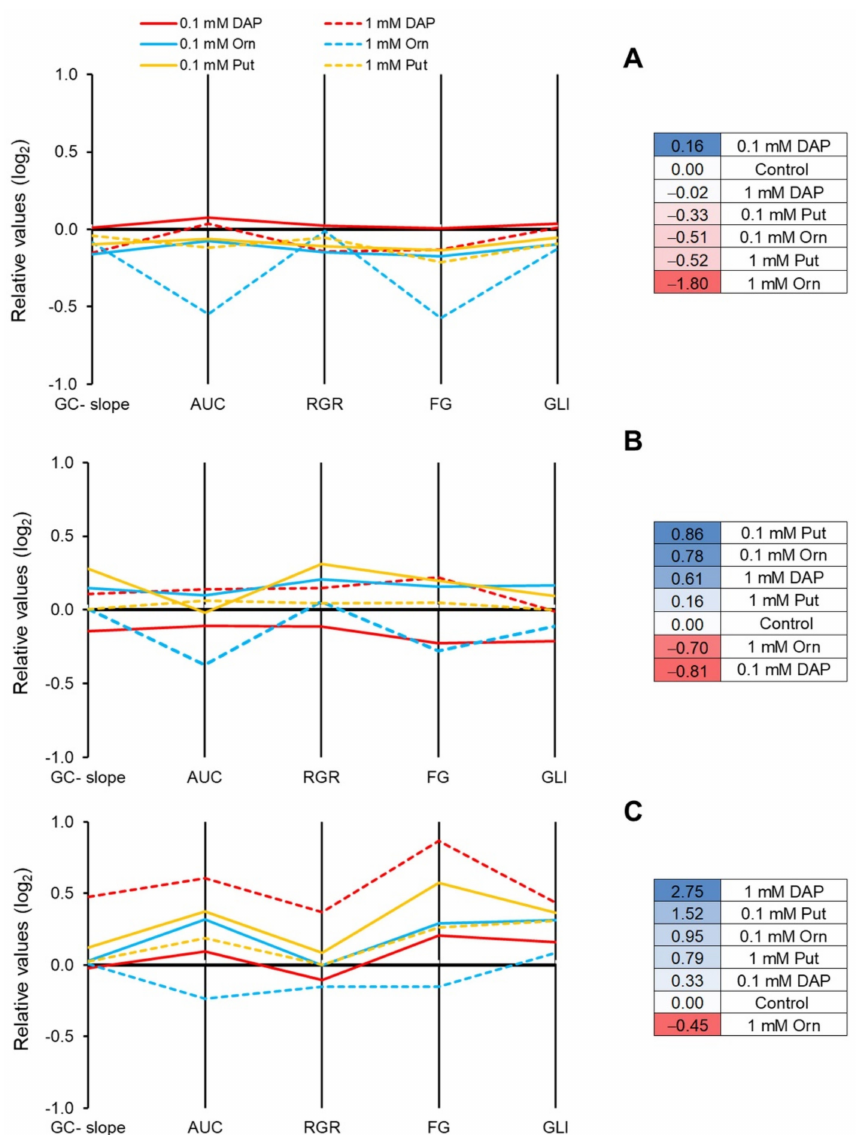
Figure 2. Parallel coordinates plot (left panel) representing all the phenotyping traits; the slope of the growth curve (GC-slope), the AUC of the growth curve, the relative growth ratio (RGR), the final size of the seedlings at the end of the experiment (FG), and the green leaf index (GLI) in Arabidopsis seedlings from primed seeds with DAP, Orn, or Put at two concentrations (0.1 or 1 mM) grown under optimal growth conditions ( A ), osmotic ( B ), and salt stress ( C ). Plant Biostimulant Characterization Index (PBCI) (right panel) is calculated as the sum of the values represented for each phenotyping trait in the parallel coordinates plot. The blue color indicates plant growth promotor under optimal conditions or stress alleviator under stress. The red color indicates a stress